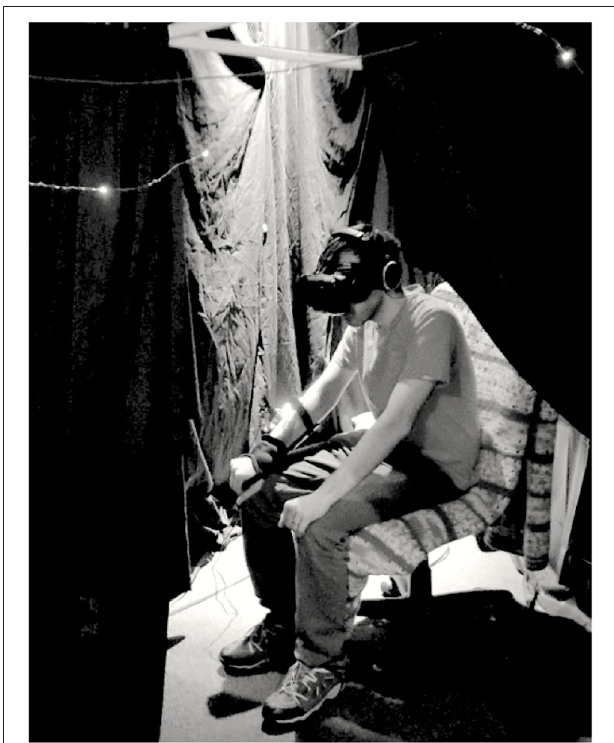
FIGURE 1 | A participant inside the tent (with the open entrance curtain) inside the “AWE” installation. The participant is seated on a swivel chair, wearing an HTC Vive (2016 model, 2,160 × 1,200 total resolution, 1,080 × 1,200 per eye, 90 Hz refresh rate at 110 ◦ diagonal field of view) and noise-canceling headphones on his head, and a goosebump camera on his right hand. Written informed consent for the publication of this image was obtained from the person depicted.